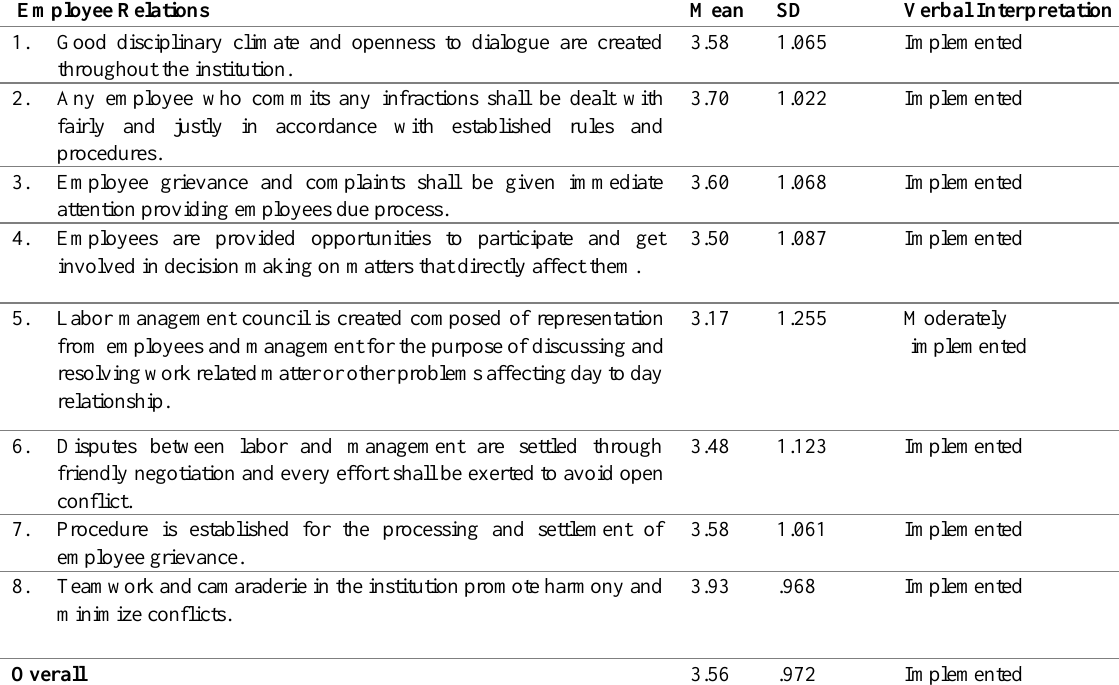
Table 2: Extent of Implementation of Leadership to Employee Relations as Perceived by Respondents Employee Relations